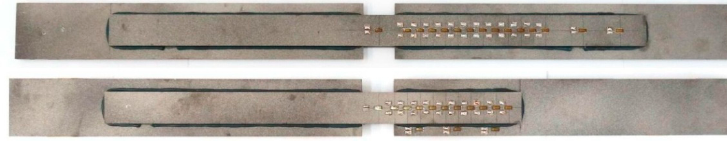
Figure 1. The specimens prepared for tests.